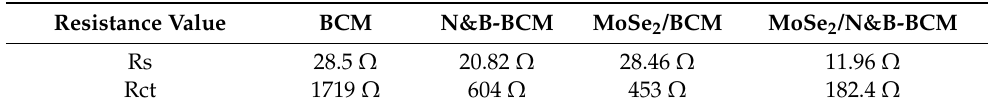
Table 1. The impedance of BCM, N&B-BCM, MoSe2/BCM, and MoSe2/N&B-BCM with sodium. (Rct: charge migration resistance, Rs: internal